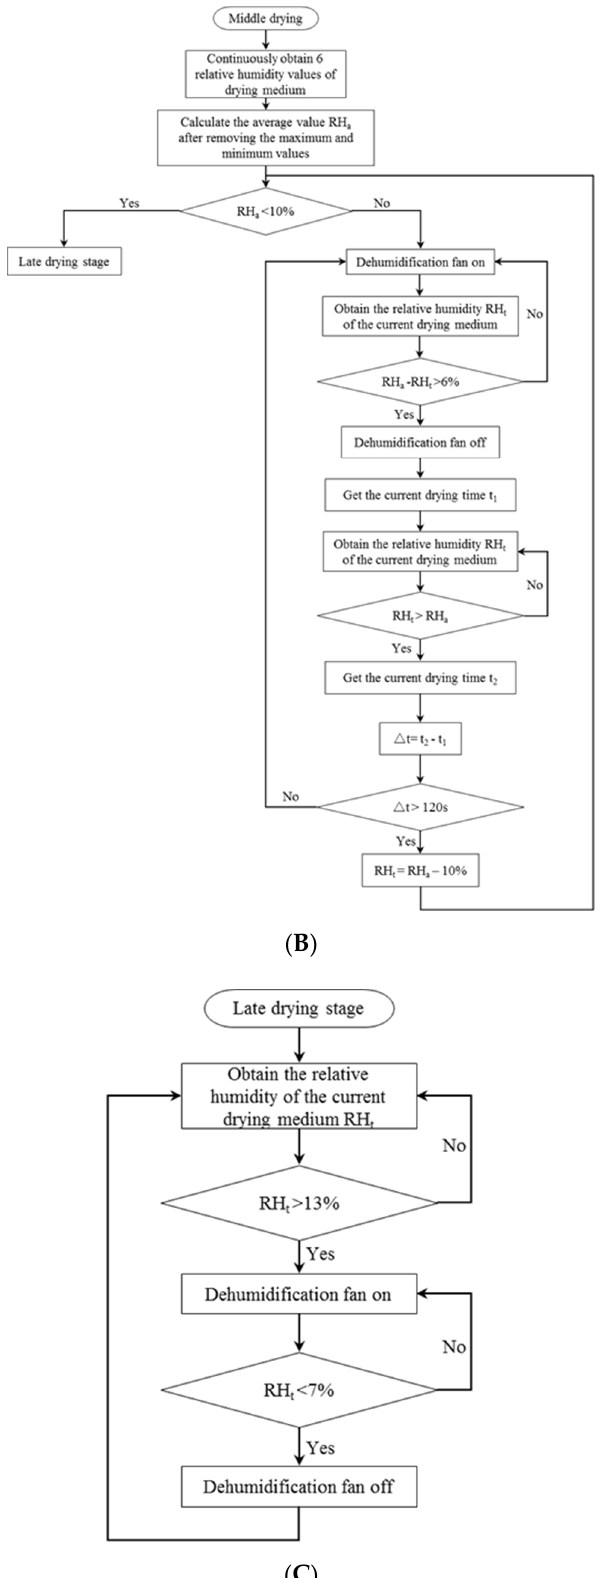
Figure 2. Flow chart of the control procedure: ( A ) control flow chart in the early drying stage; ( B ) control flow chart in the middle drying stage; ( C ) control flow chart in the late drying stage.